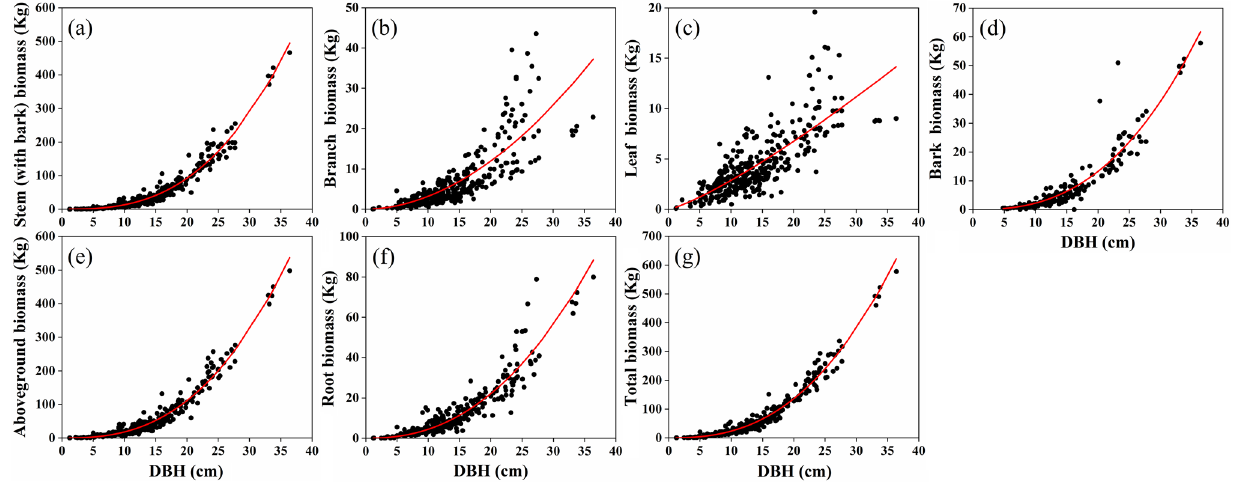
Figure 4. Relationships of component biomass against diameter at breast height. ( a – g ) Stand for stem (with bark), total branch, total foliage, aboveground, total root, and total biomass,